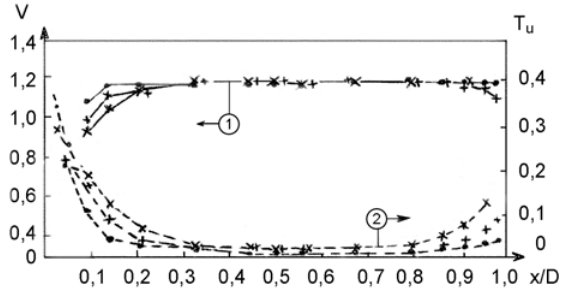
Fig 9. Profile of creasing longitudinal velocity of stream ( V ) and degrees of turbulence ( Tu ) in identical sections of empty experimental apparatus without sedimentation at the charge corresponding number Re D = 24 400 at various distances from a cut tip (A. Sakalauskas' experiments): ● – distance from a cut tip h = 10 mm; + – distance from a cut tip h = 30 mm; х – distance from a cut tip h = 60 mm